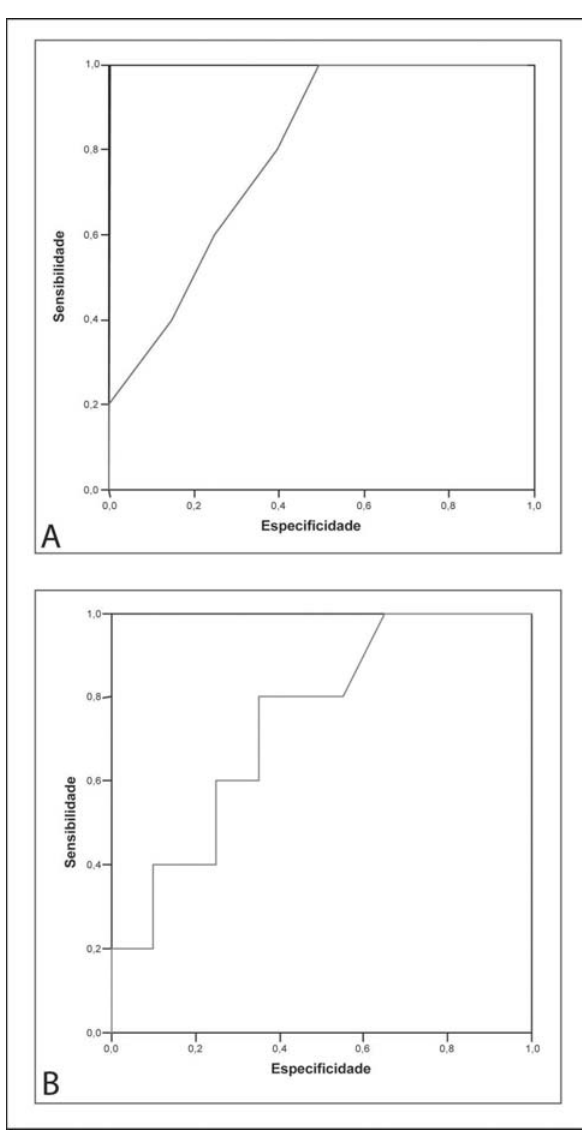
Fig. 1. – A: Análise da curva ROC para volume of cristalóide; B: Análise da curva ROC para valores pré-operatórios de IL-8